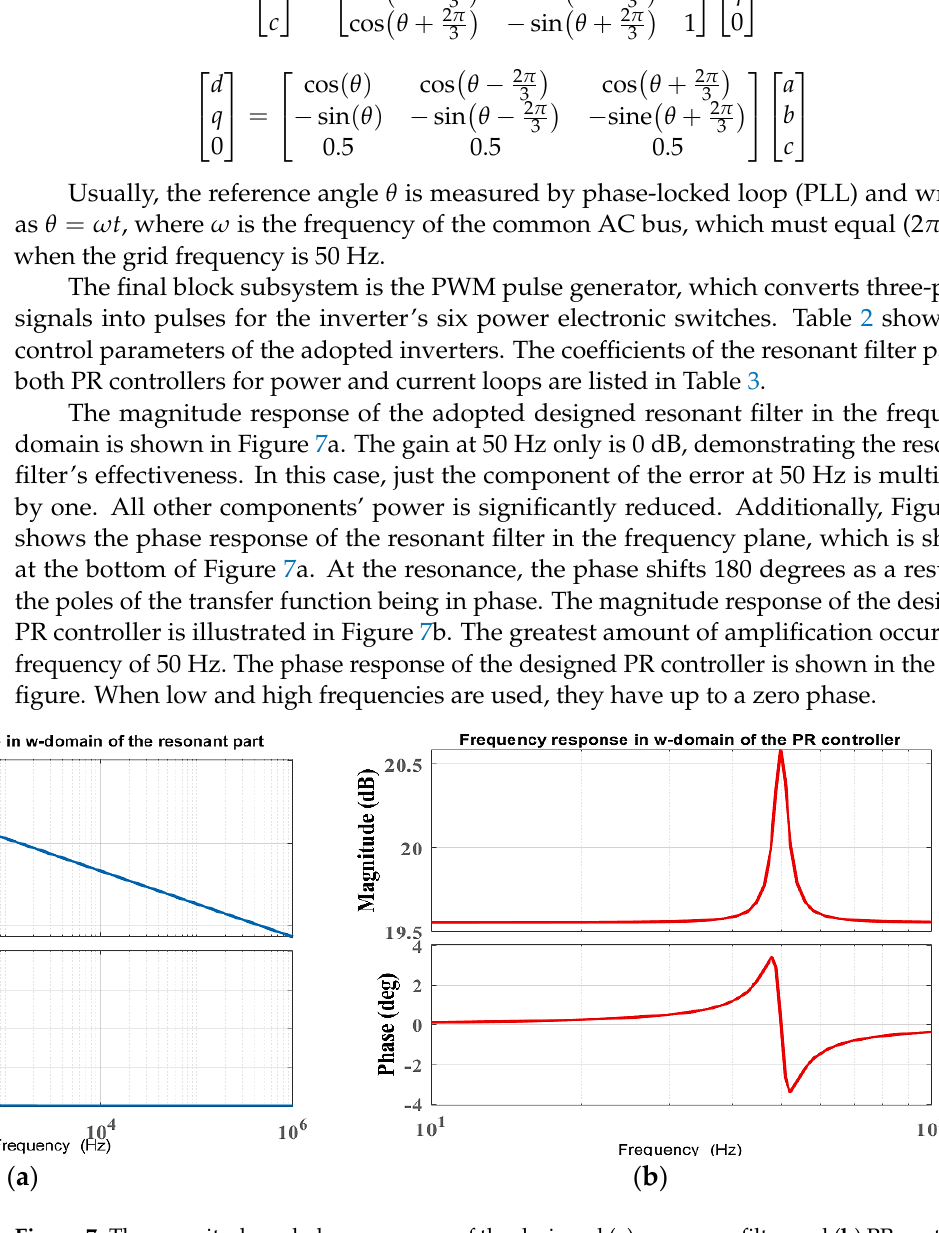
Table 4. Power and current loops ’ PR resonant filter parameters.